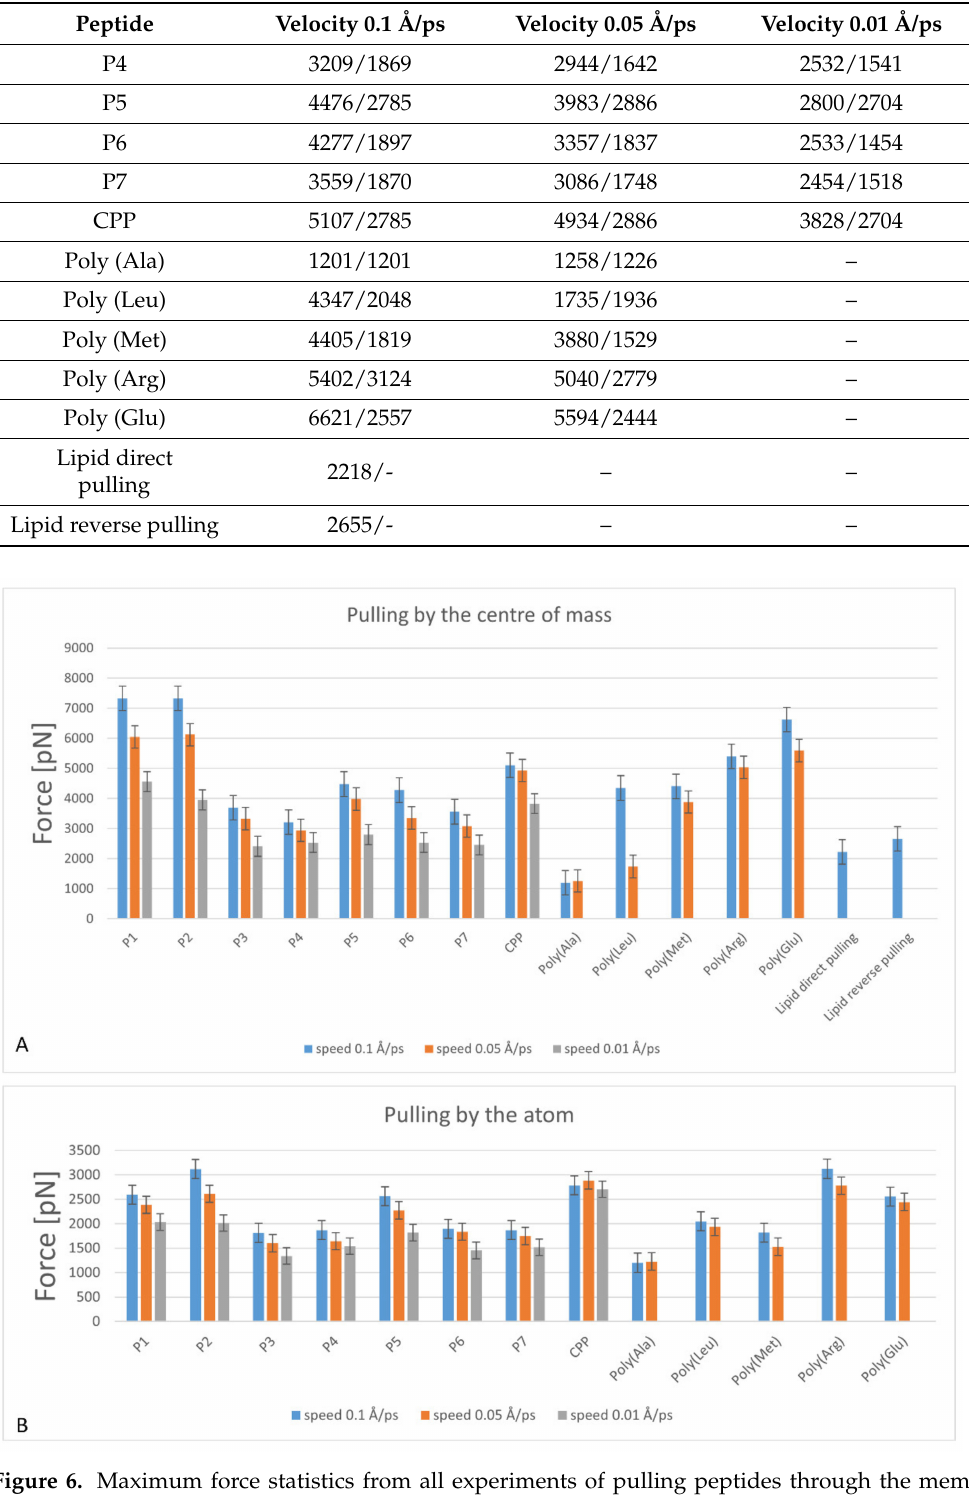
Figure 6. Maximum force statistics from all experiments of pulling peptides through the mem- brane: ( A ) by the center of mass, ( B ) by the terminal atom. Every column is an averaging of 8